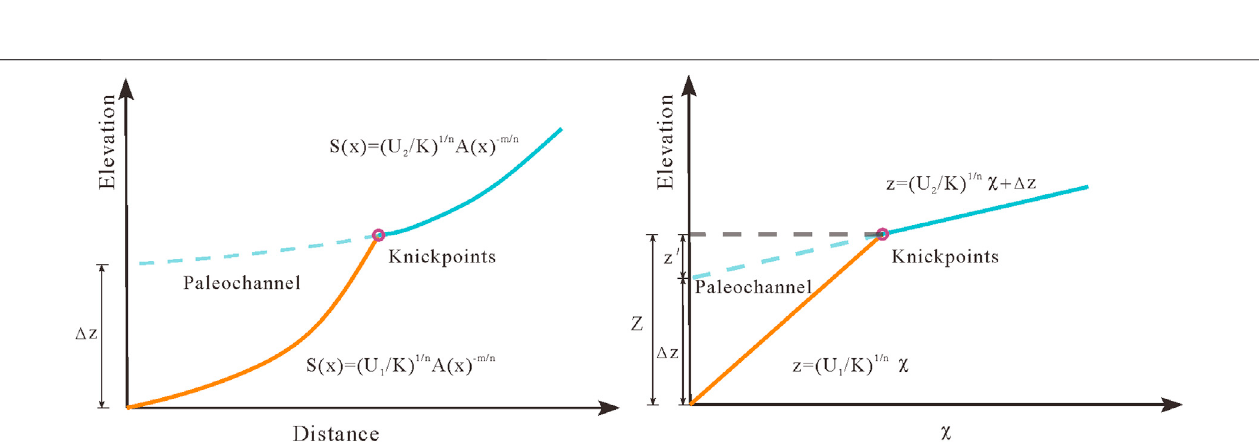
FIGURE 2 | Channel pro fi le differences between the two types of knickpoints (blue indicates the upstream channel of the crack; orange indicates the channel downstream of the crack; purple indicates the knickpoints) [modi fi ed from Kirby and Whipple, (2012)].